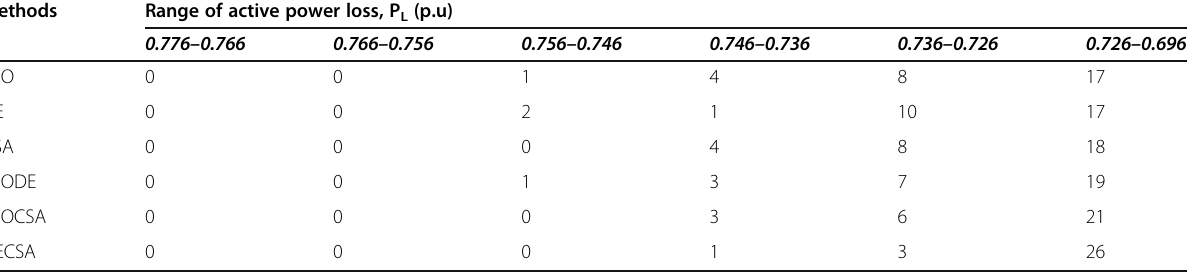
Table 11 Convergence recurrence of P L on Indian 62-bus system with 30 trials